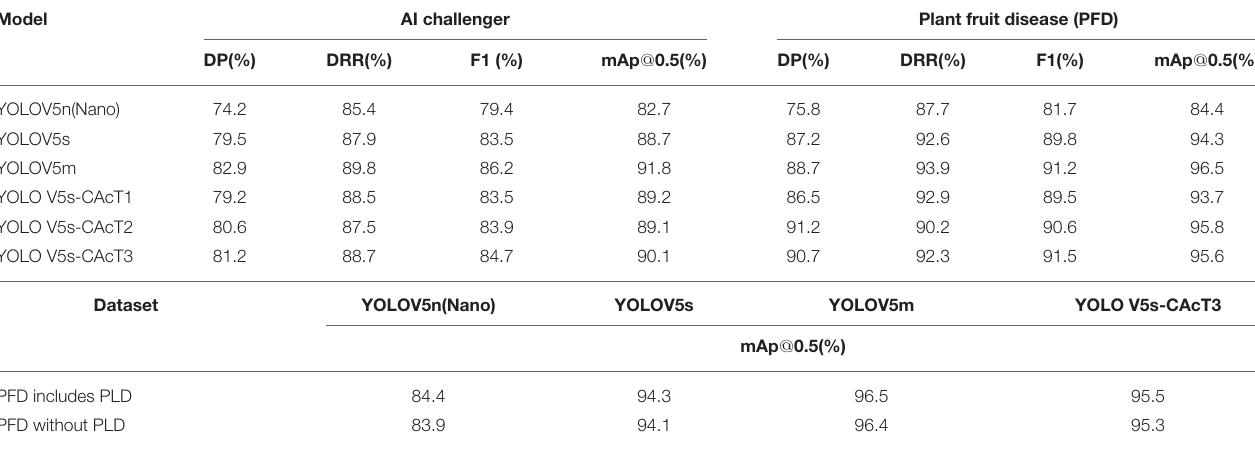
TABLE 5 | AI challenger and PFD dataset model training results.